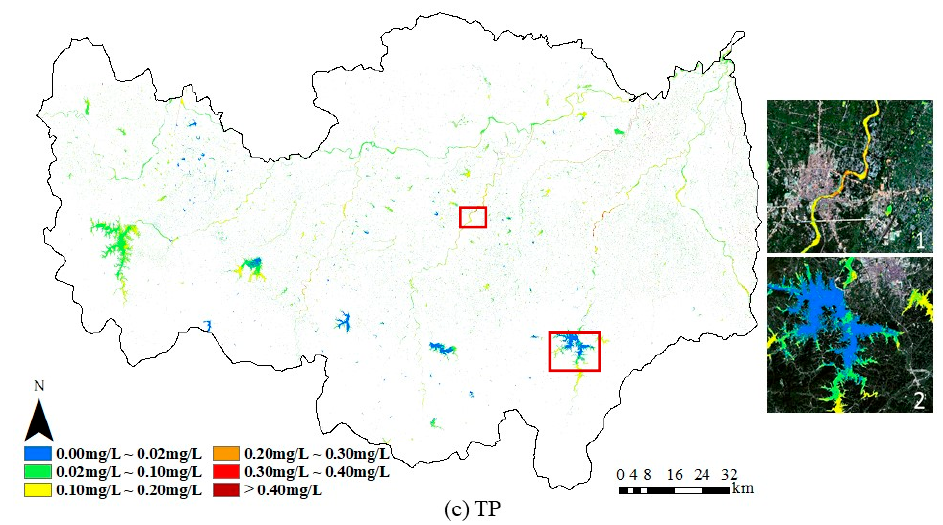
Figure 9. The spatial distribution of NH 3 -N, COD and TP in the Xinyang section of Huaihe River Basin; 1 is part of the Huanghe River; 2 is part of the Nianyushan reservoir. ( a ) The spatial distribution of NH 3 -N; ( b ) the spatial distribution of COD; ( c ) the spatial distribution of